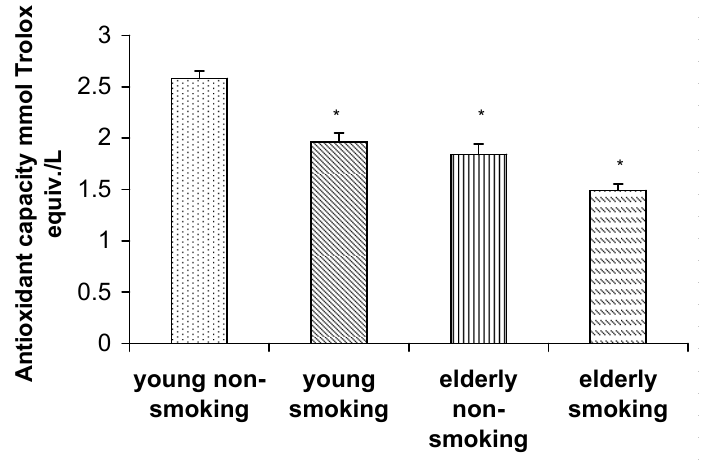
Fig. 1 Antioxidant capacity of plasma in young and elderly non-smoking and smoking volunteers (mean ± SE; asterisk represents P < 0.001; vs. young